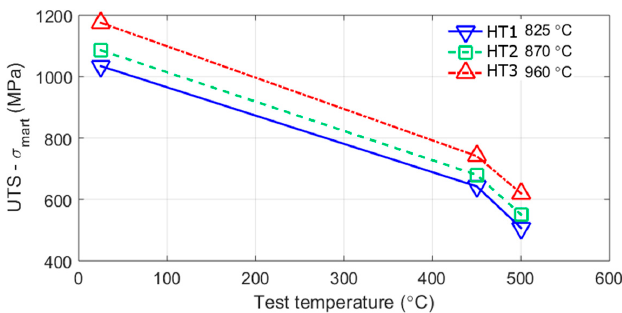
Figure 12. The change in ultimate tensile strength (UTS) minus the strengthening from martensite σ mart (a), of an alloy with a similar composition to that measured here and reported in [8], the alloy is called Alloy B, see start of discussion for more details. The three heat-treatments have the same austenitisation temperatures in this report and are aged for 5 h; the higher austenitisation temperatures (HT3 and HT2) are aged at 540 °C, and 825 °C at 560 °C (HT1). Being able to estimate creep performance is more difficult than predicting strength because the martensite and precipitates change during the course of creep; diffusional mechanisms (Coble or Nabarro-Herring creep) will occur in addition to the dislocation mechanisms. However, in the present case, where the test stress is high relative to the yield strength and the temperature low relative to the melting temperature, dislocation slip is expected to be the dominant mode of deformation. A good example of why this should be the case is the increase in creep life with reduced prior austenite and martensitic grain sizes seen at similar creep conditions in other work on this alloy [19]. The increased tensile strength and hardness of the 7.5 h aged samples austenitised at the higher temperature would therefore also be expected to perform better during creep tests. From Figure 12, on this alloy with slightly different processing, which we are calling alloy B [8], it can be seen that the increased room-temperature strength from the higher austenisation temperature (HT3 in this case), is maintained at higher temperatures. This is not always the case as shown for the effect of martensitic microstructure shown in another work on the alloy [19]. The SANS results suggest that precipitate evolution during creep would lead to lower creep strains and greater creep rupture times at the higher austenitisation conditions; this is because the strength difference between the heat-treatments increases with ageing time and thus may also be expected to increase during creep testing. The cause of this is mainly a result of the relative growth of smaller and larger Laves phase at the different austenitisation temperatures, with the smaller ones contributing more to strengthening, for the same volume fraction, than the larger ones.